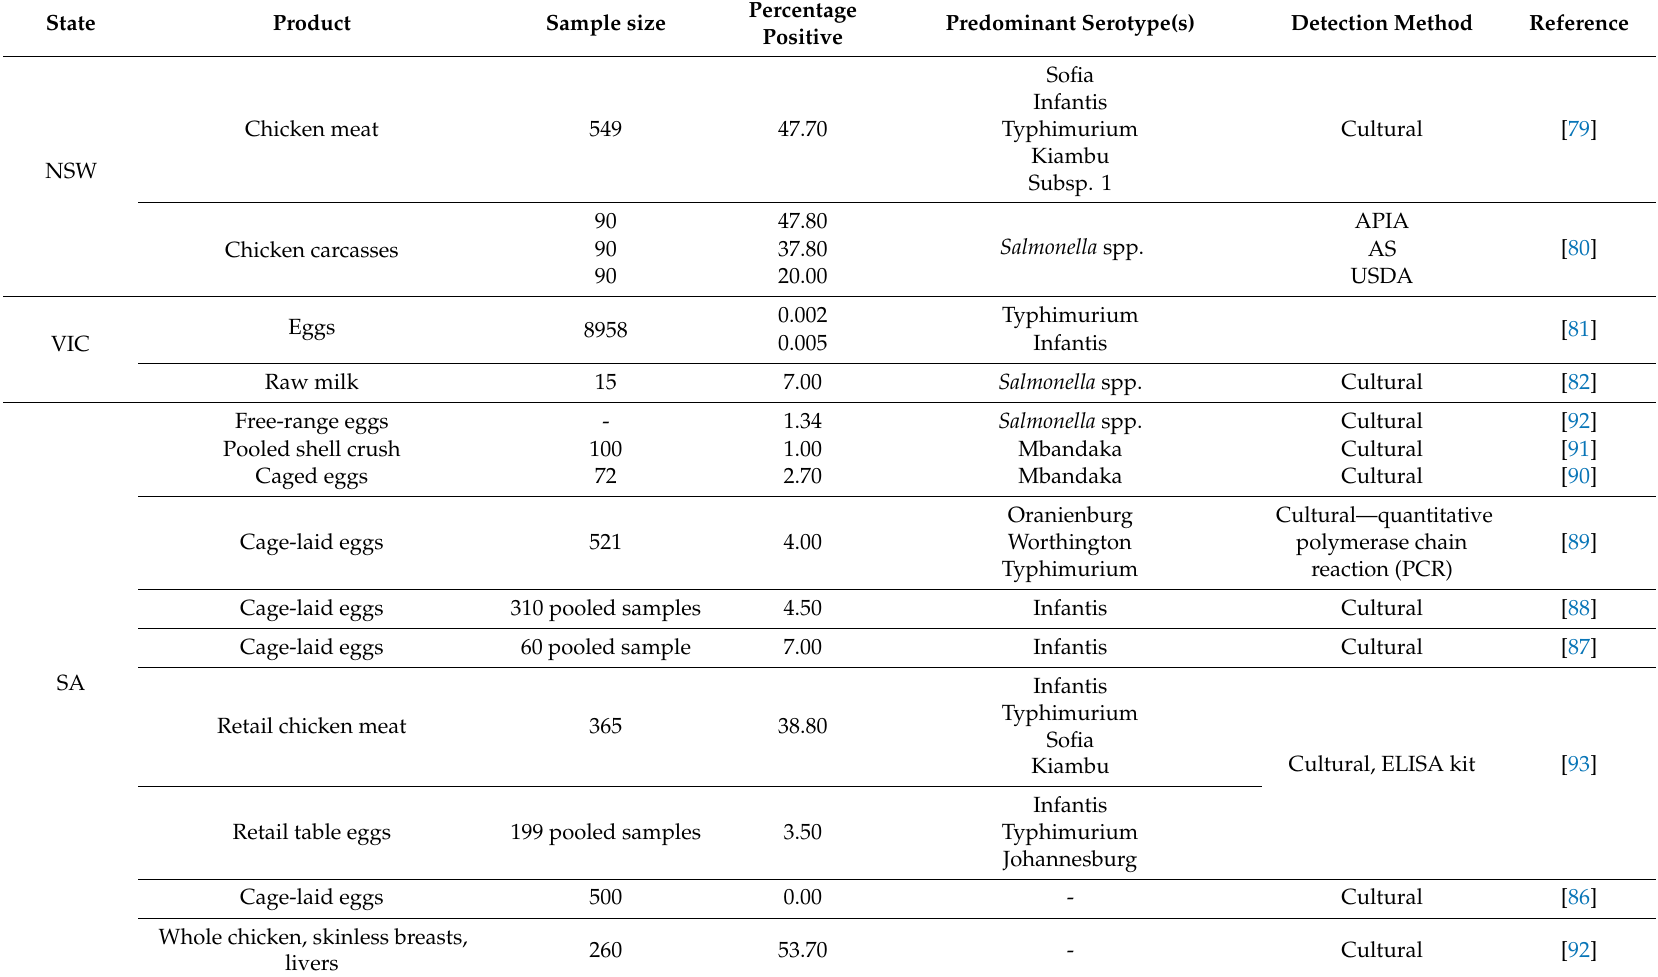
Table A2. Occurrence of non-typhoidal Salmonella in foods of animal